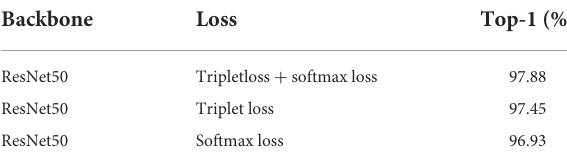
TABLE 3 Comparisons of different backbone networks on validation sets.